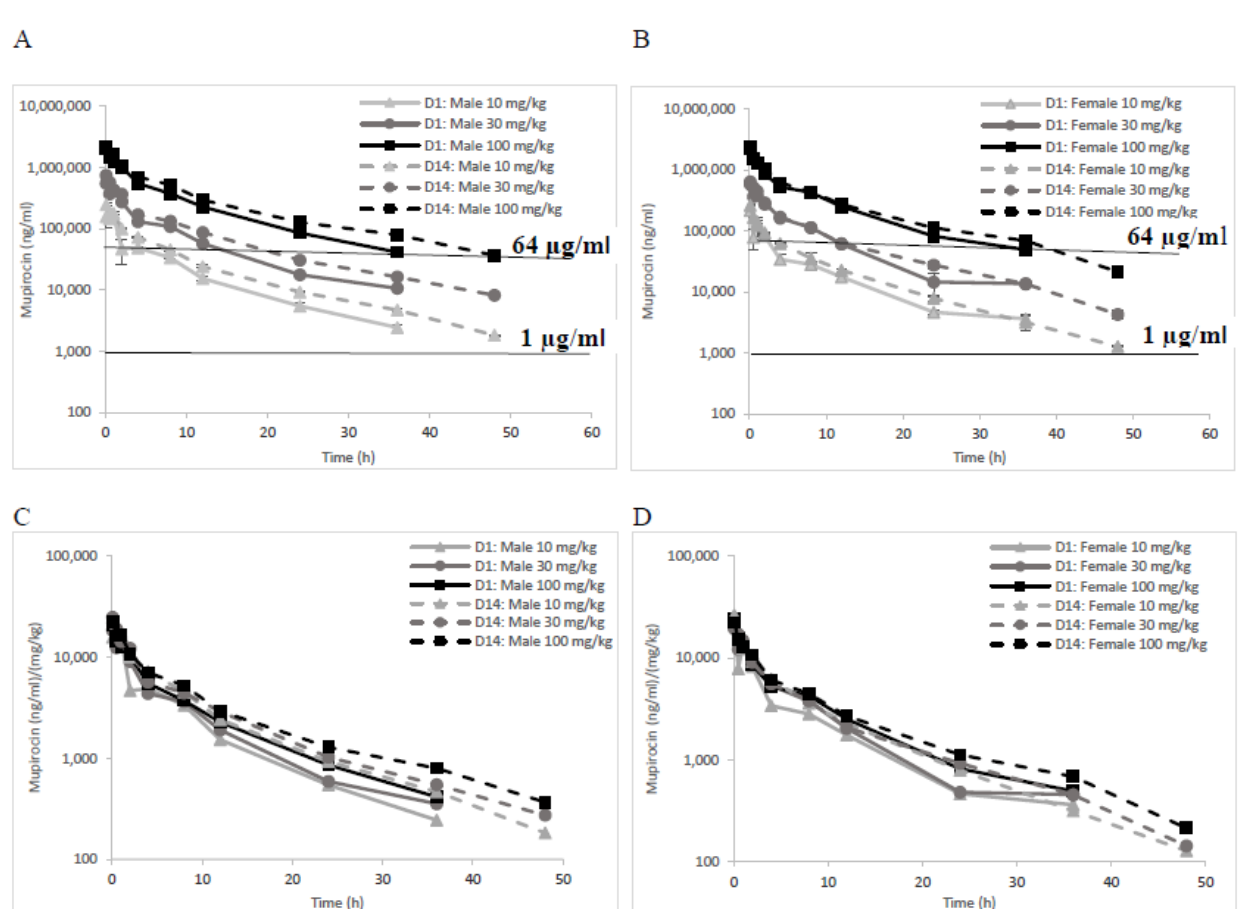
Figure 1. Total mupirocin (liposome-encapsulated plus non-liposomal drug plus plasma-protein-bound drug) concentration (ng/mL) following IV administration of 10, 30 and 100 mg/kg Nano-mupirocin to male ( A ) and female ( B ) rats on days 1 and 14. ( C , D ) represent normalization of the profiles to the doses ( n = 3, mean ± SE). The horizontal line of 1 µ g/mL in ( A , B ) corresponds to the MIC for most Gram-positive isolates (except E. faecalis ), and the 64 µ g/mL line to the maximal MIC for MRSA with low-level mutational-type mupirocin resistance .